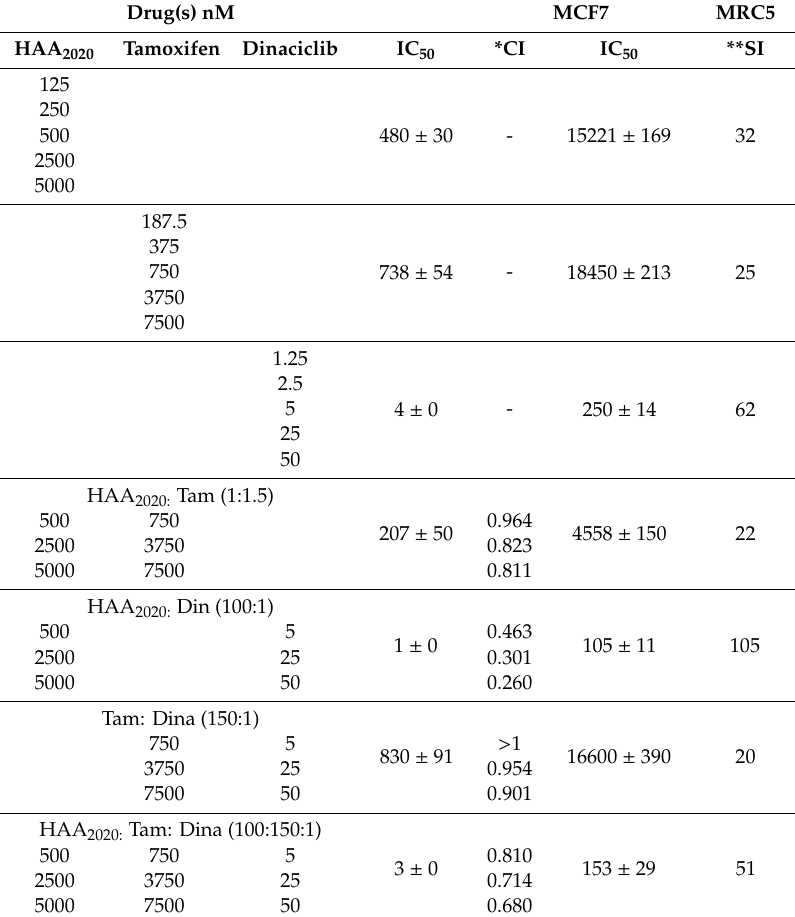
Table 3. IC 50 values (72 h, nM), combination index, and selectivity index of HAA 2020 , tamoxifen, dinaciclib, and their